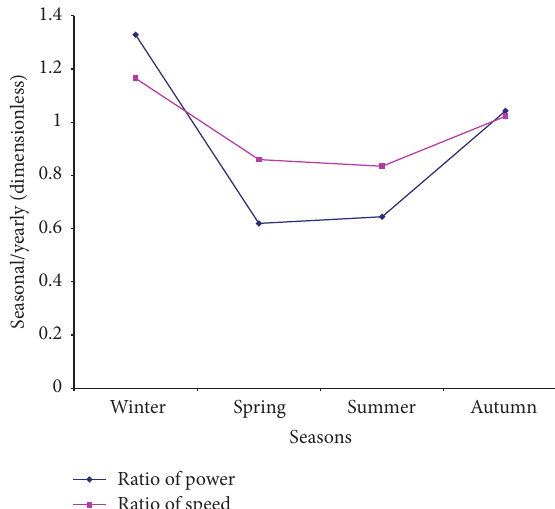
Figure 10: (Seasonal/annual) ratio of mean wind power density and 10 m wind speed for the period 1980–2009 in the ECS.